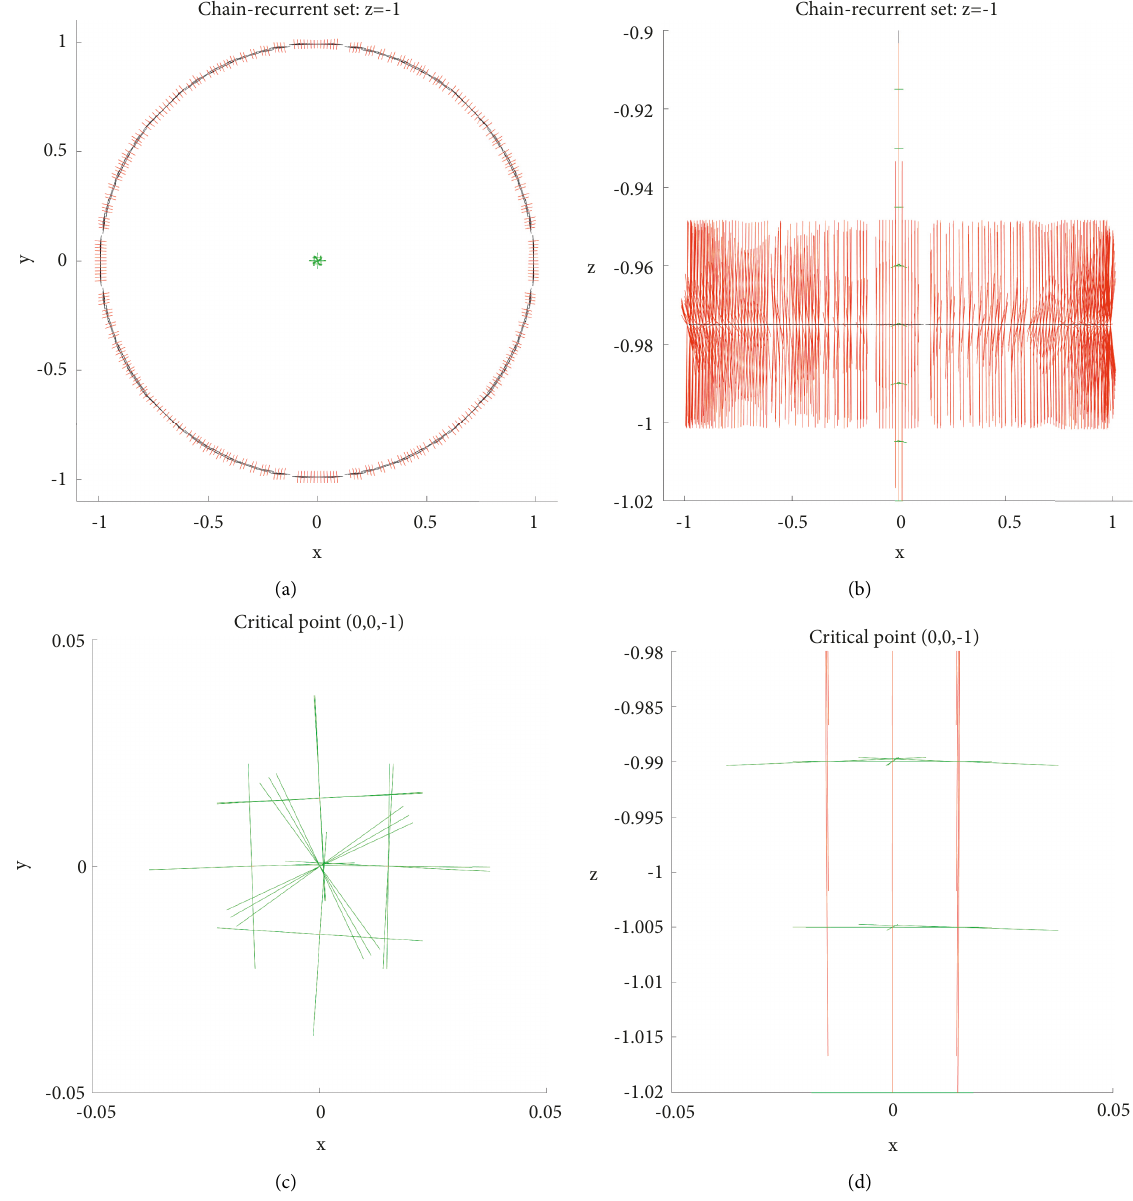
Figure 11: System (21). z � − 1, periodic orbit Ω ( 0 , 0 , − 1 ) in the xy -plane (a) and in the xz -plane (b). Ω − 1 and equilibrium at − 1 has a two- dimensional unstable manifold (in z -direction and towards the equilibrium). Equilibrium ( 0 , 0 , − 1 ) in the xy -plane (c) and in the xz -plane (d). Two-dimensional stable manifold (in xy -plane) and one-dimensional unstable manifold (in z